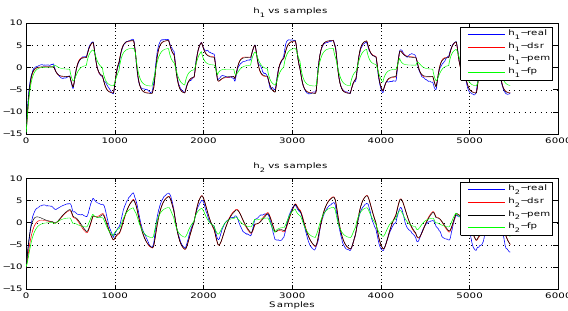
Figure 7: This figure illustrates the real measurements of the level in the two lower tanks as well as the corresponding simulated outputs of the system identification models, from DSR and PEM, as well as the simulated outputs from the first principles